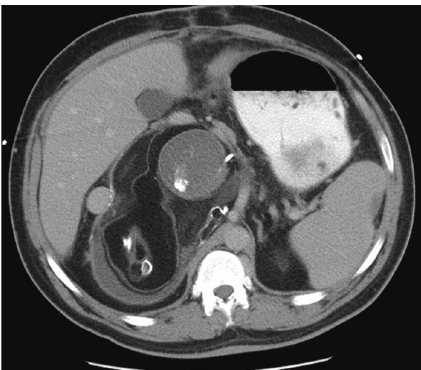
Figure 2: CT scan with contrast shows a retroperitoneal mass containing bone, soft tissue, and cystic elements.